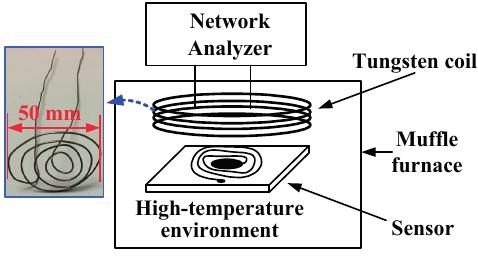
Figure 9. High-temperature testing system.